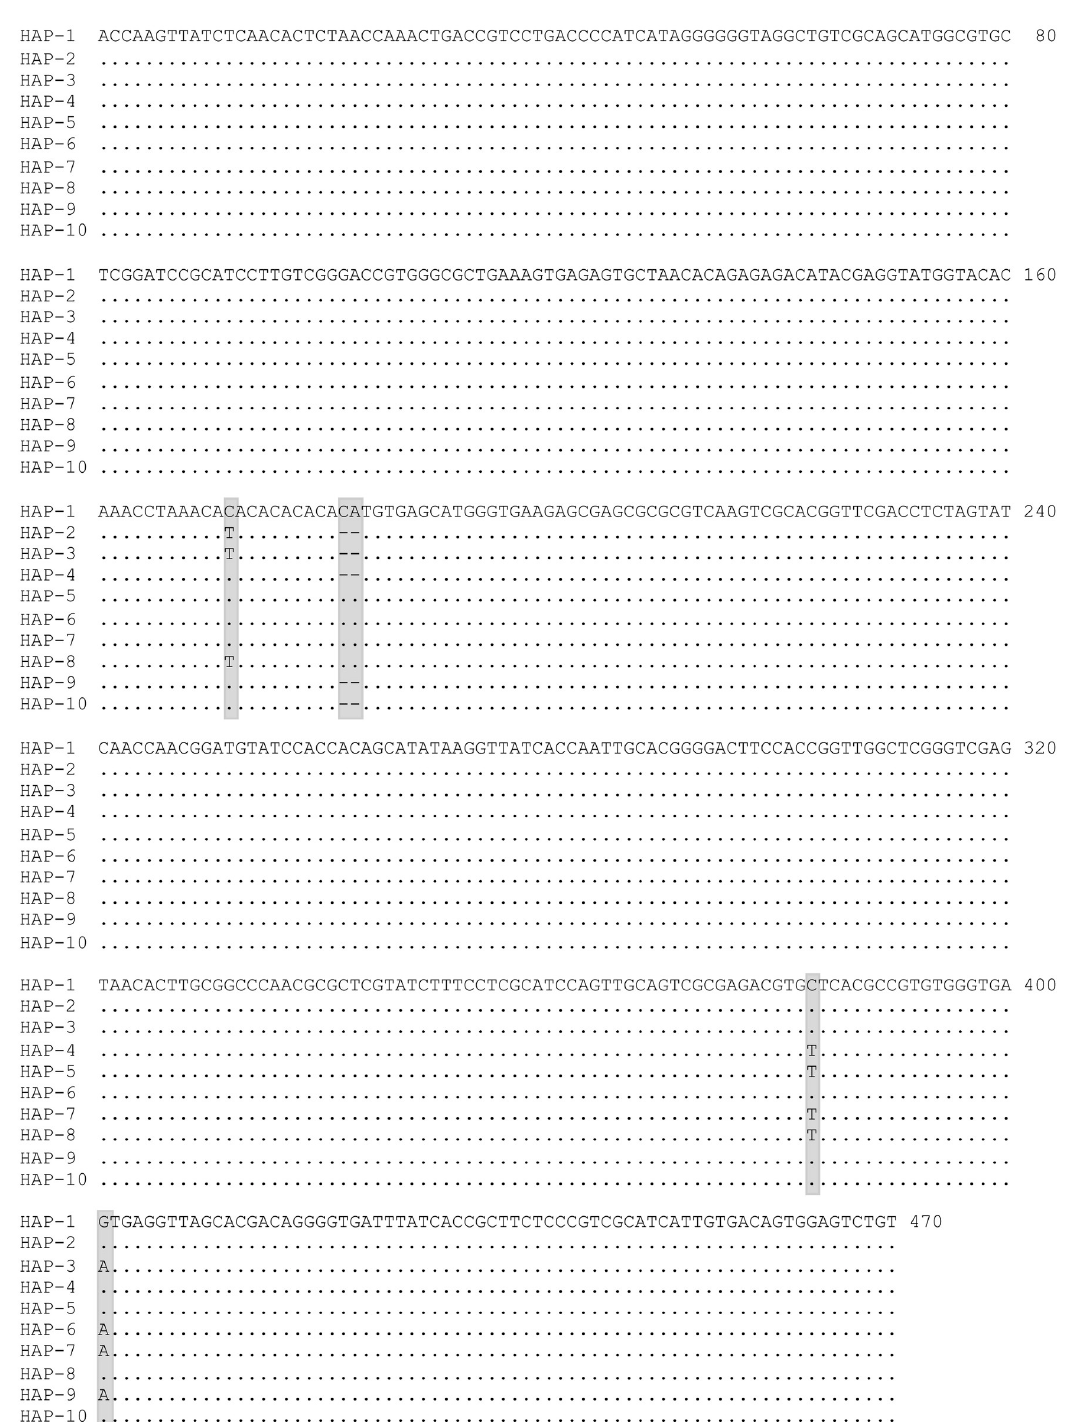
PLOS ONE | https://doi.org/10.1371/journal.pone.0253173 June 14,